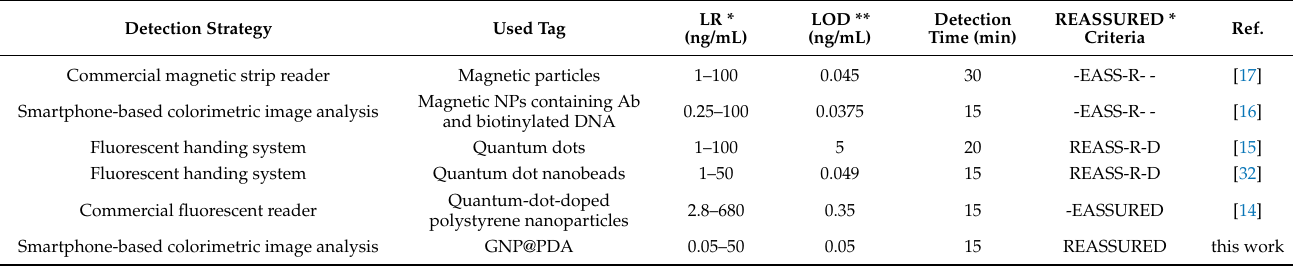
Table 3. Comparison of some characteristics of our developed smartphone-based LFIA kit with recently reported LFIA-based portable systems, in terms of the quantification of CEA.